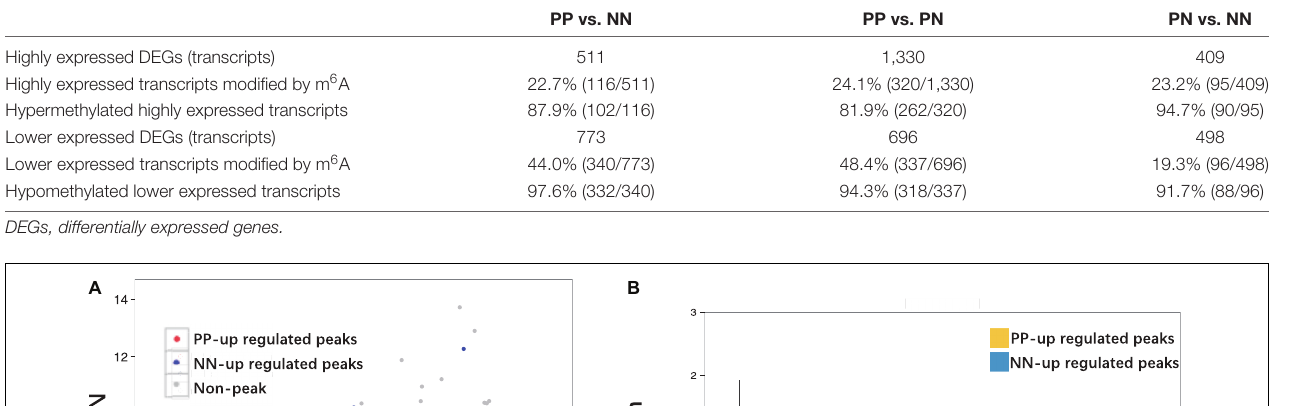
TABLE 2 | Relationship between m 6 A peaks and mRNA level. PP vs. NN PP vs. PN PN vs. NN